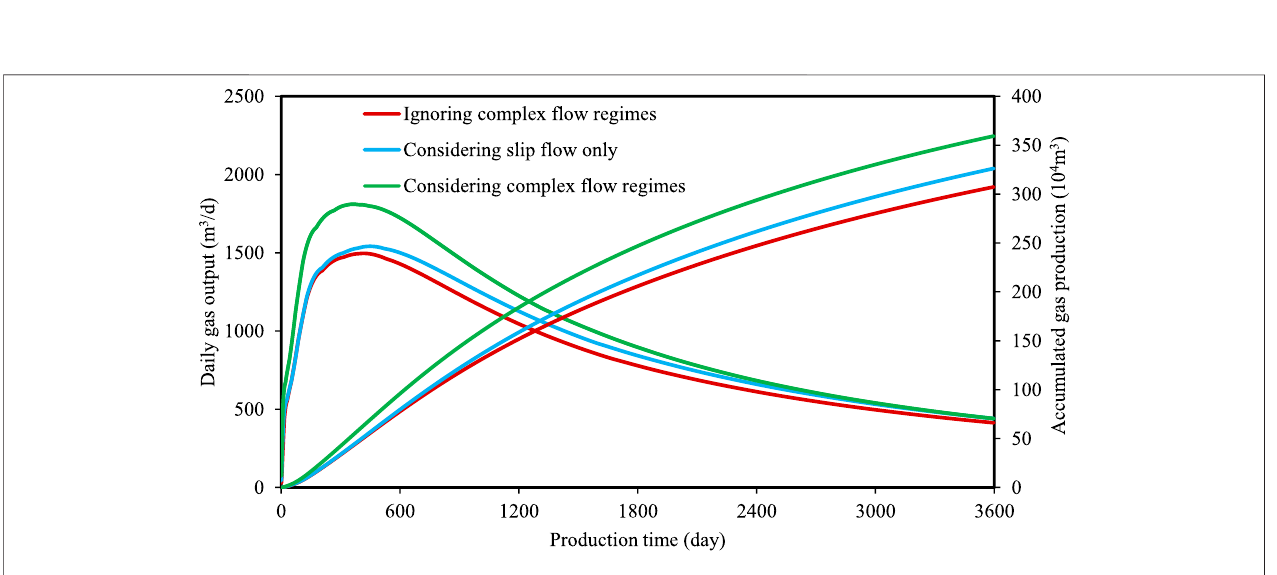
FIGURE 6 | Effects on gas production when whether complex fl ow regimes are considered or not.